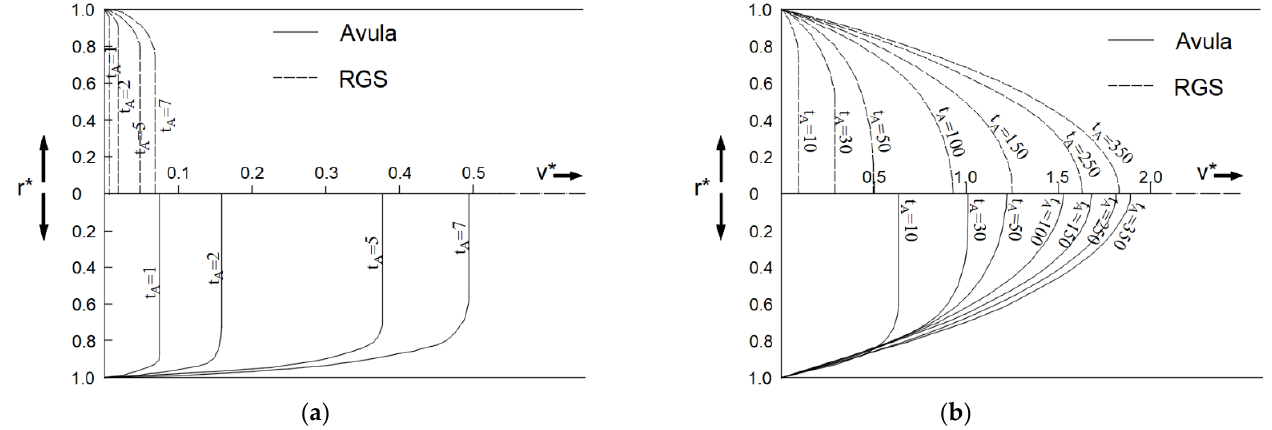
Figure 6. Velocity profiles comparison of RGS and Avula solutions for relatively: ( a ) small times; ( b ) large times (adapted from [53]).